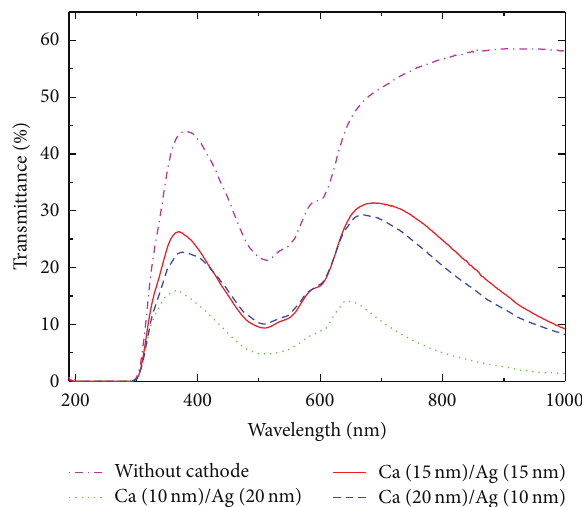
Figure 5: The wavelength-dependent transmittance spectra of ITO-free semitransparent OSCs with different thickness combina- tion of Ca and Ag as the cathodes. For comparison, the trans- mittance spectrum of the stack MoO 3 (2 nm)/Ag (9 nm)/MoO 3 (10nm)/P3HT:PCBM (the device without the cathode) is also depicted in Figure 5. Bottom illumination from the anode side is applied for measurement.